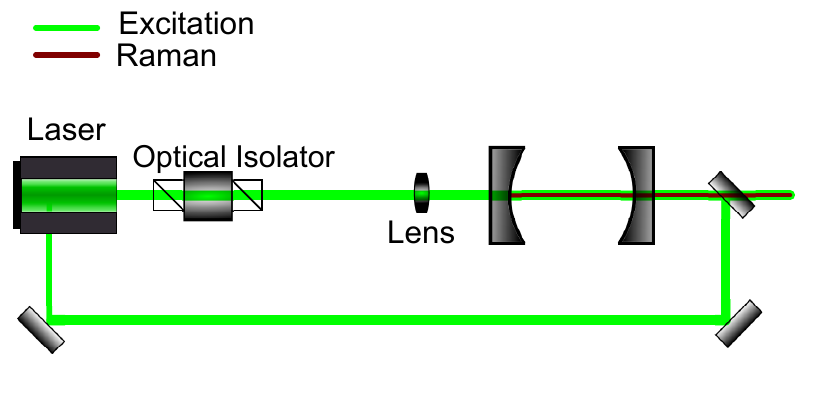
Figure 6. Schematic setup for optical feedback frequency-locking. The emitted light out of the cavity is injected back into the source laser to enforce a resonant frequency. Table 2. Optical cavity locking methods and their advantages and disadvantages. Locking Method Advantages Disadvantages flexibility to either vary the laser PDH need for high cost electronics frequency itself or the cavity length Optical feedback frequency